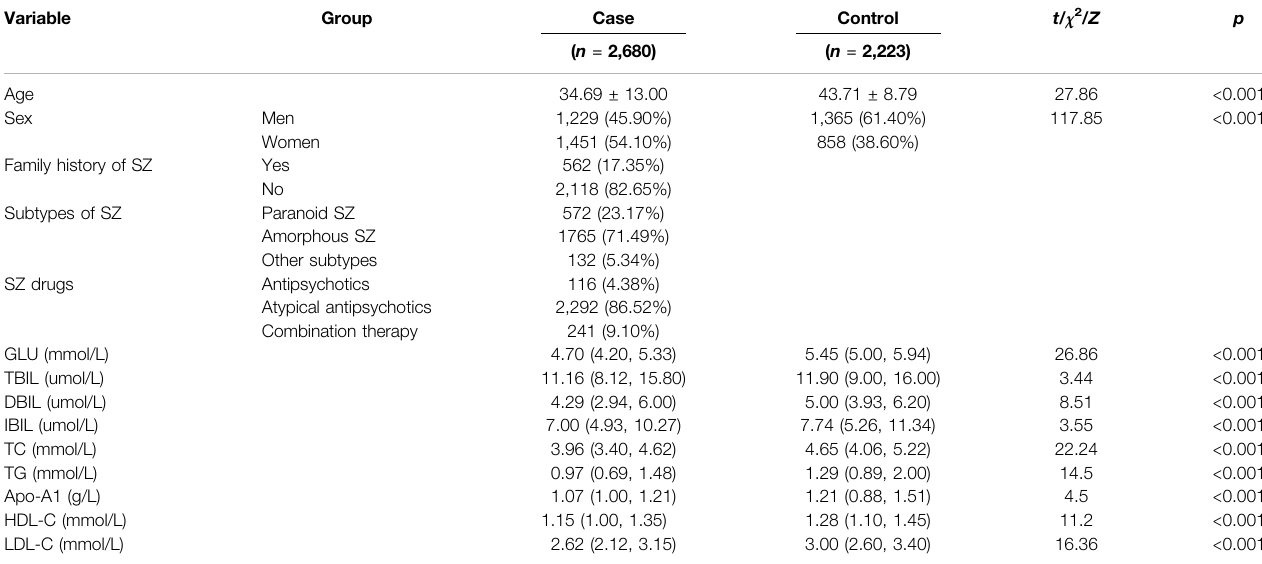
TABLE 1 | Demographic and clinical characteristics of SZ cases and controls.